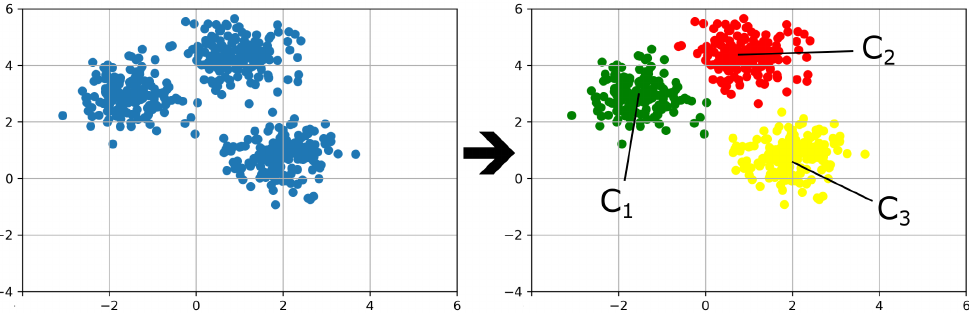
Figure 3. Clusters in the 2-dimensional space. The left plot indicates the initial data and the plot on the right side corresponds to the identified clusters, denoted as C 1 (Cluster 1), C 2 (Cluster 2), and C 3 (Cluster 3).